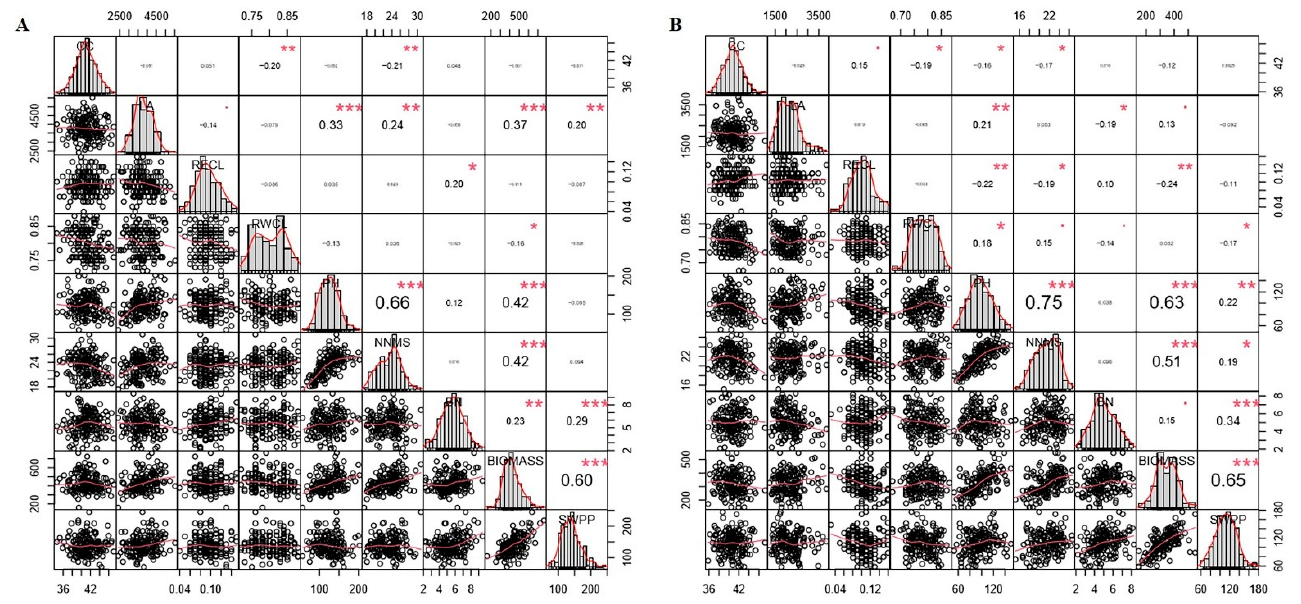
Figure 2. Pearson’s correlation coefficients (r) describing associations of two physiological traits and seven agronomic traits of 162 soybean genotypes evaluated under well-watered condition and drought stress condition. ( A ) The correlation analysis among the traits under well-watered condition. ( B ) The correlation analysis among the traits under drought stress condition. LA, leaf area; PH, plant height; BN, branch number; CC, chlorophyll content; RWCL, relative water content of leaves; RECL, relative electric conductivity of leaves; NNMS, node number of main stem; BIOMASS, biomass; SWPP, seed weight per plant. The diagonal line shows the distribution of the nine traits. The bivariate scatter plot with fitted lines is displayed below the diagonal line. The correlation coefficient and significant difference are shown above the diagonal line, and the higher correlation coefficient is, the greater the numerical code. The red dot * represents significant difference at p < 0.05; the red dot ** represents significant difference at p < 0.01; the red dot *** represents significant difference at p < 0.001.